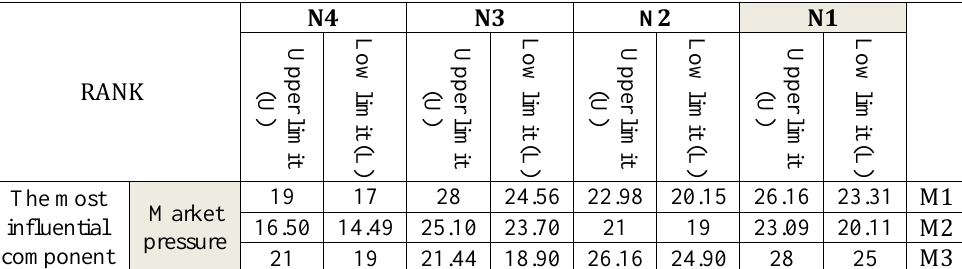
Table 10. Decision analysis distance analysis matrix